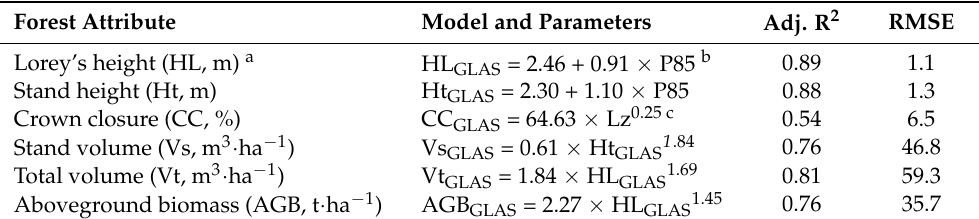
Table 2. Geoscience Laser Altimeter System (GLAS) models of forest attributes along with model form and coefficients, goodness of fit (adj. R 2 ) and root mean square error (RMSE) values (adapted from Tables 3 and 4a in